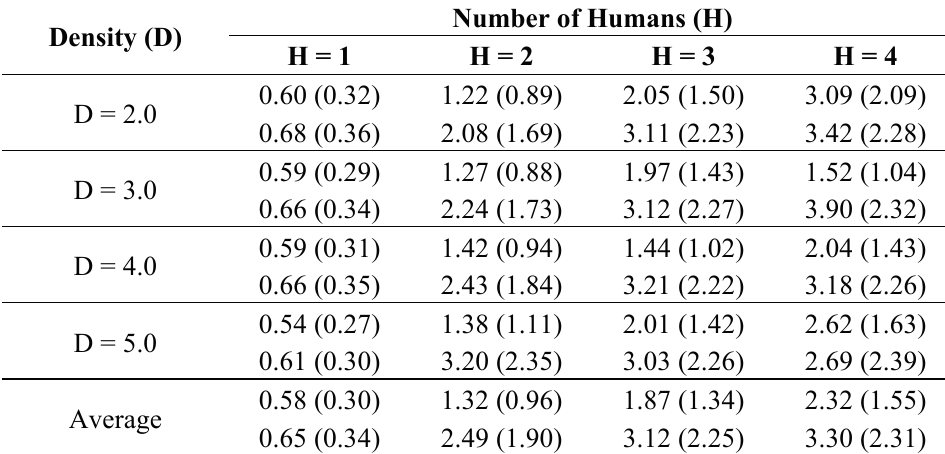
Table 3. Averaged error of the estimated path (Unit: m).